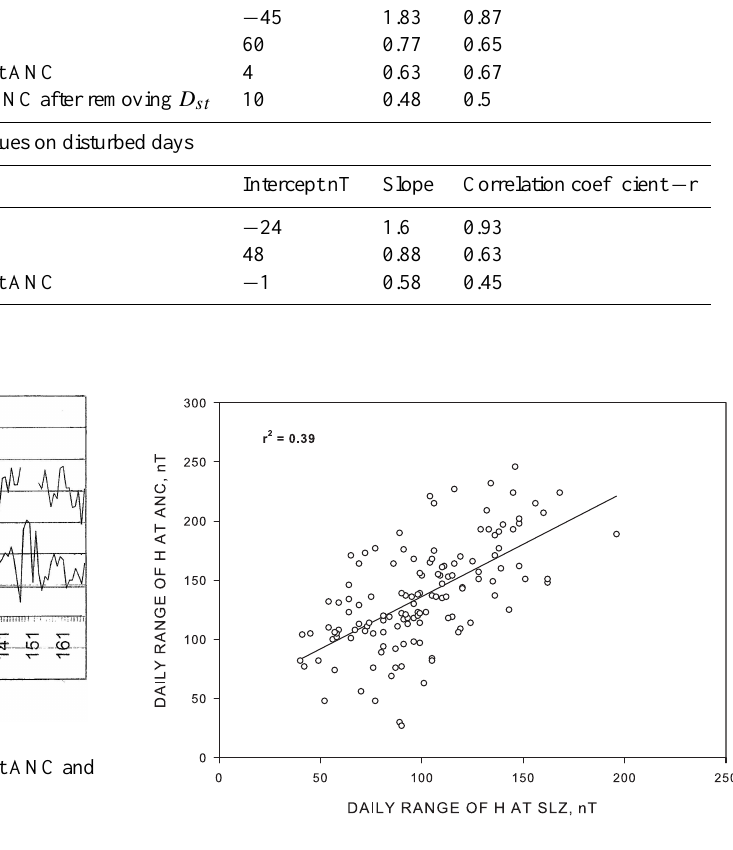
Fig. 2b. Mass plot of the daily range of H at ANC plotted against the values at